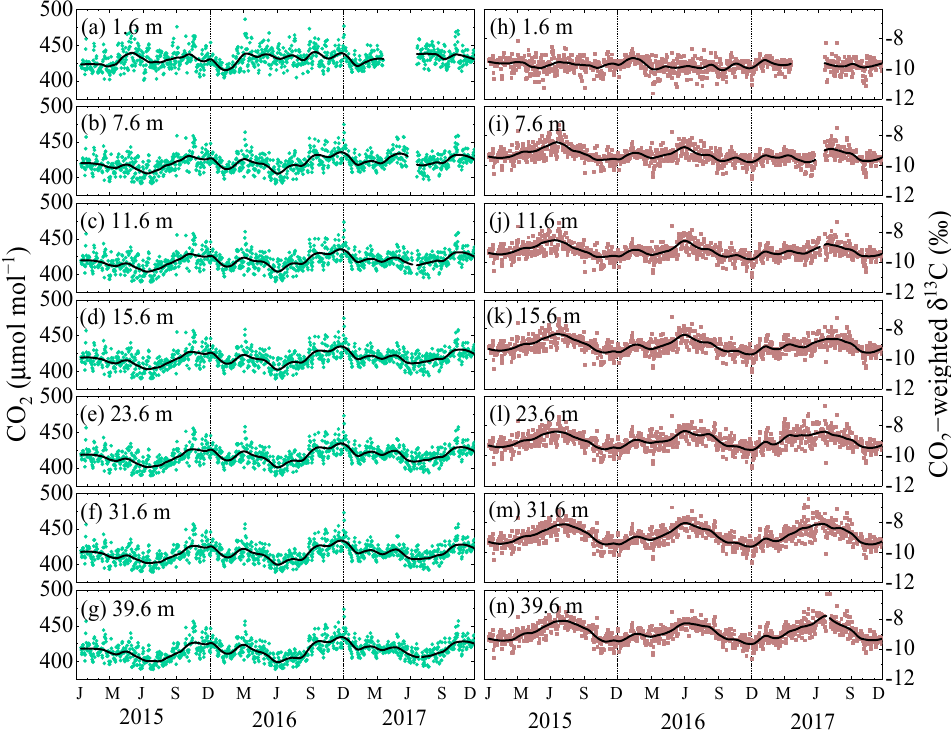
Figure 4. Seasonal variations in daily ecosystem CO 2 ( a – g ) and its weighted δ 13 C ( h – n ) below (1.6 and 7.6 m), within (11.6 and 15.6 m) and above (23.6, 31.6, and 39.6 m) the canopy (2015–2017). The black curves represent locally weighted smoothing lines.